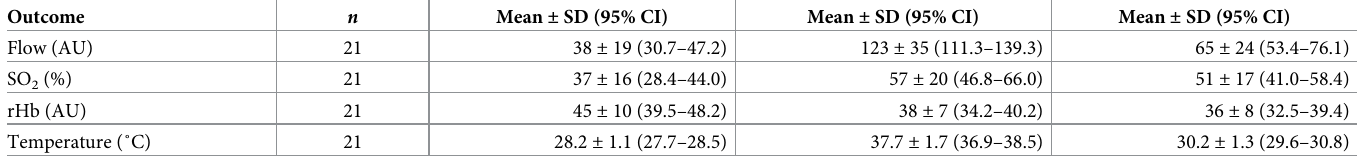
Table 2. Descriptive statistics.